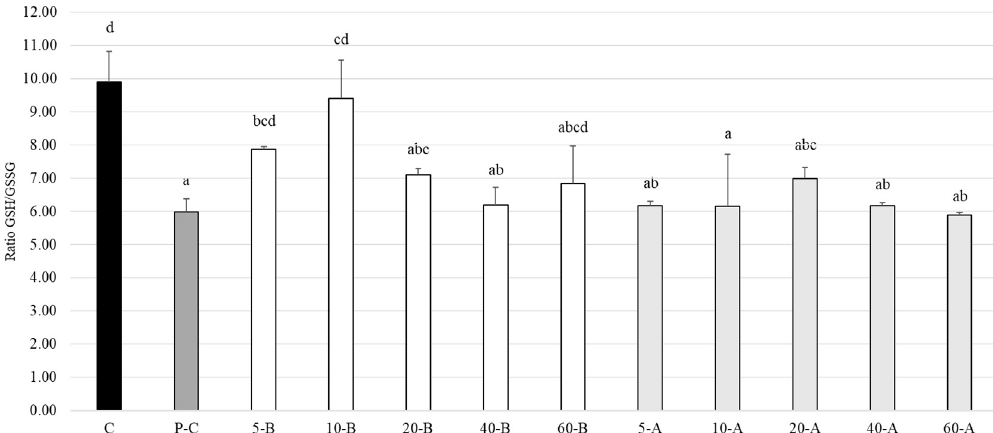
Figure 7. Effects of the broccoli extracts with different SFN concentrations on the ratio of GSH/GSSG in RAW264.7 macrophages. All data are presented as the mean ± SD ( n = 3). Different letters in the same row indicate significantly different results ( p < 0.05).